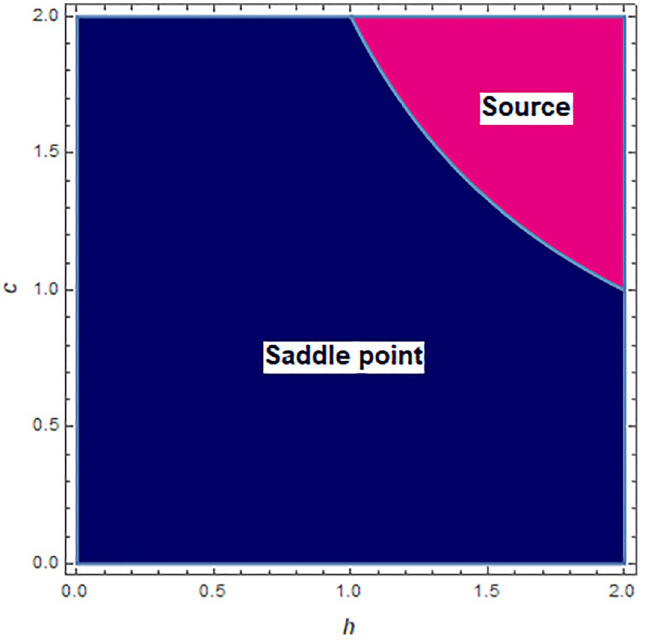
Figure 1. Topological classification of boundary fixed point p 0 ( 0, 0 ) at h